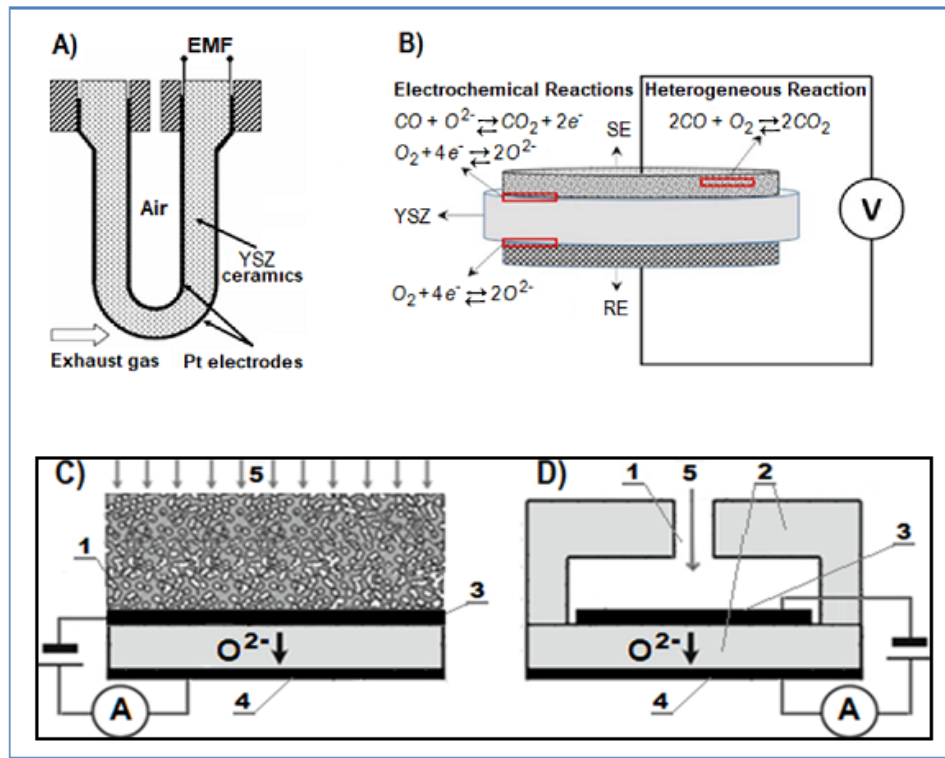
Figure 1. ( A ) A typical potentiometric sensor for the detection of oxygen in exhaust gases. Repro- duced with permission from [16]; ( B ) schematic representation of a typical mixed potential sensor with YSZ electrolyte and porous electrodes, reproduced with permission from [15]; ( C , D ) schematic representation of amperometric sensors: (1) the diffusion barrier, (2) the solid electrolyte, (3) cathode, (4) anode, and (5) surrounding gas. Reproduced with permission from [17,18].